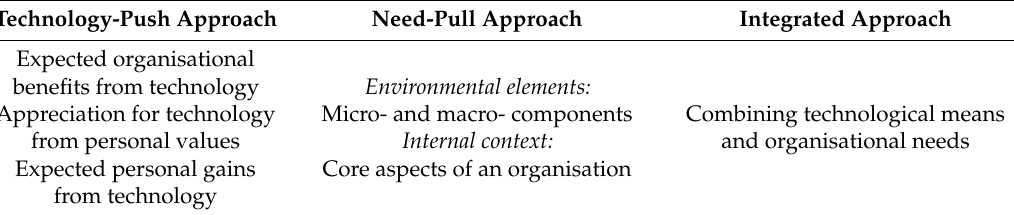
Table 1. Summary of the variation in technology adoption